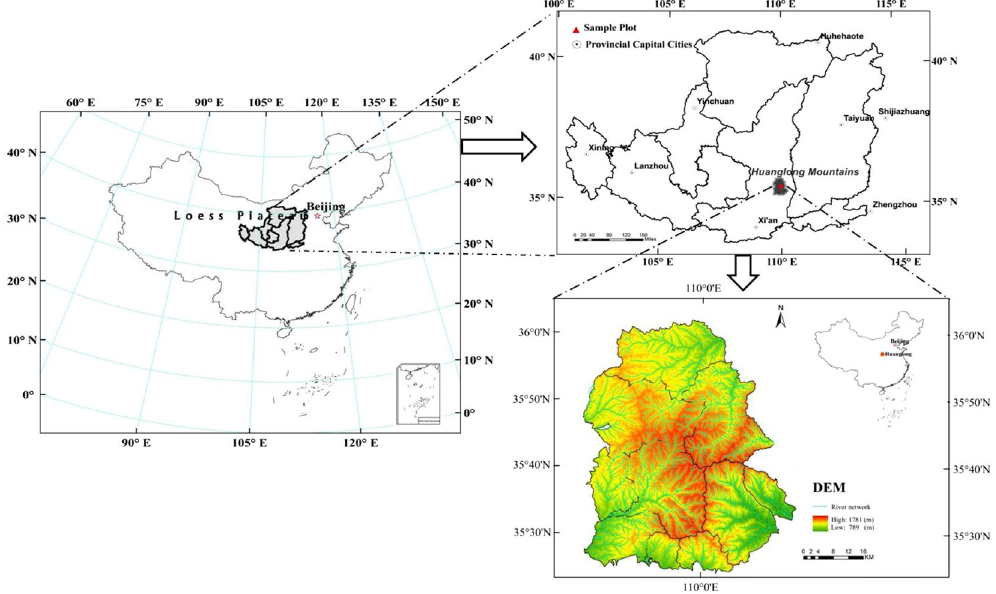
Figure 1. Location of the Loess Plateau and sample plot. The software of Arc GIS 10.2 was used to generate the maps, which was from the Digital Forestry Laboratory in College of Forestry, Northwest A&F University, and was bought in 2014.